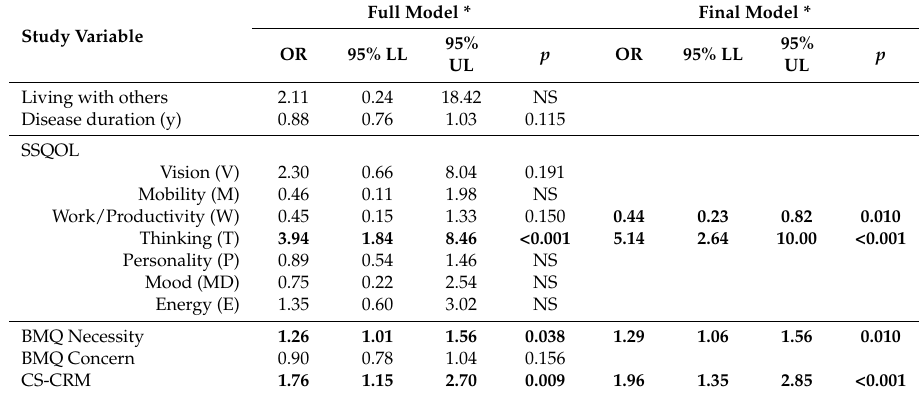
Table 4. Multivariate modelling of study variables on treatment compliance (optimal vs. all other) of stroke